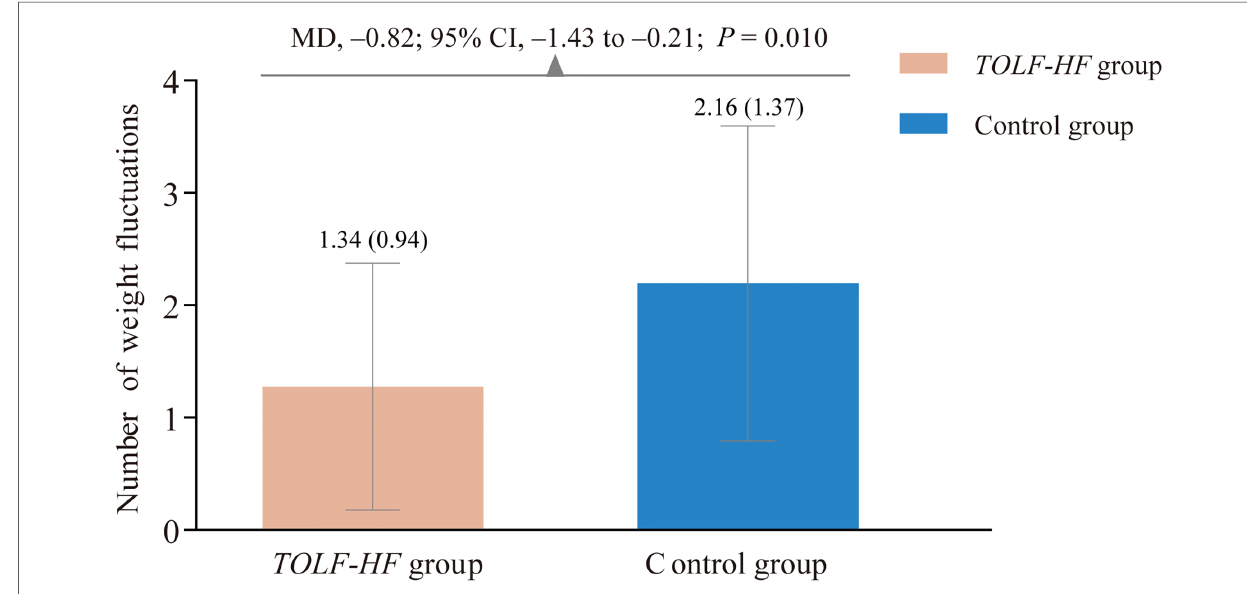
FIGURE 3 Column bar graph showing the comparison of the number of abnormal weight gains between the TOLF-HF intervention and control groups. MD, mean difference; CI, con fi dence interval.